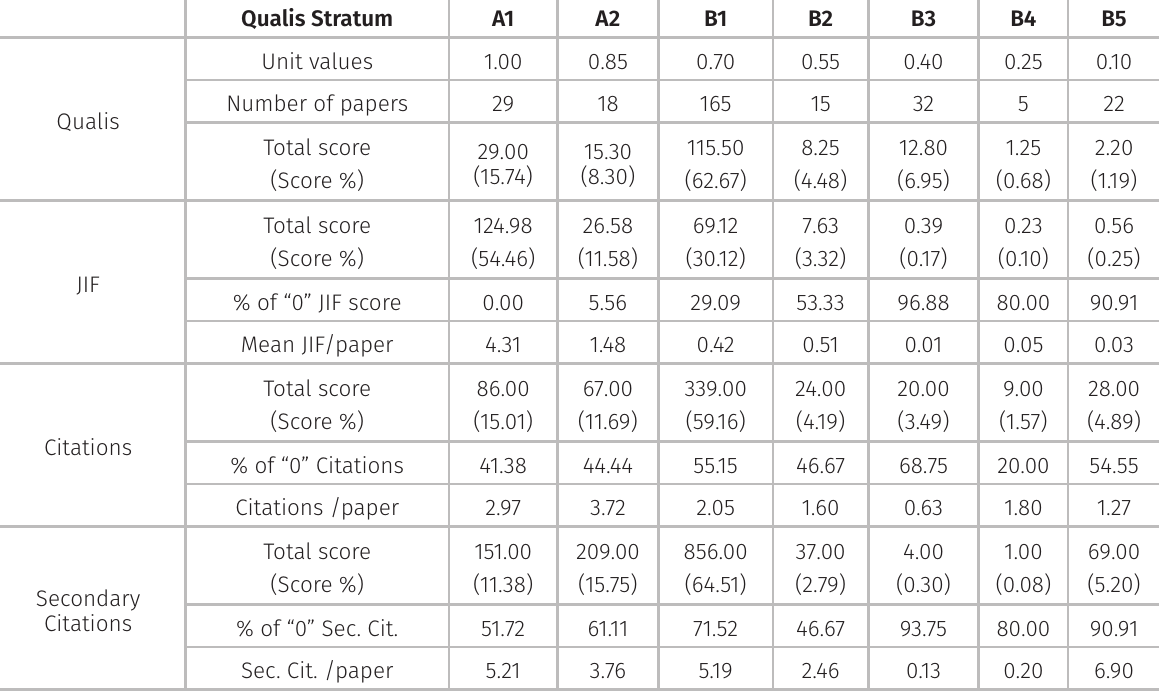
Figure 2. Scores obtained using the Qualis, JIF, Citation, Secondary Citations and H-Index criteria for evaluating Brazilian postgraduate program. Table III. Total Qualis score, JIF, Citations and Secondary Citations for the sample for the different Qualis strata, referring to the 2015 to 2018